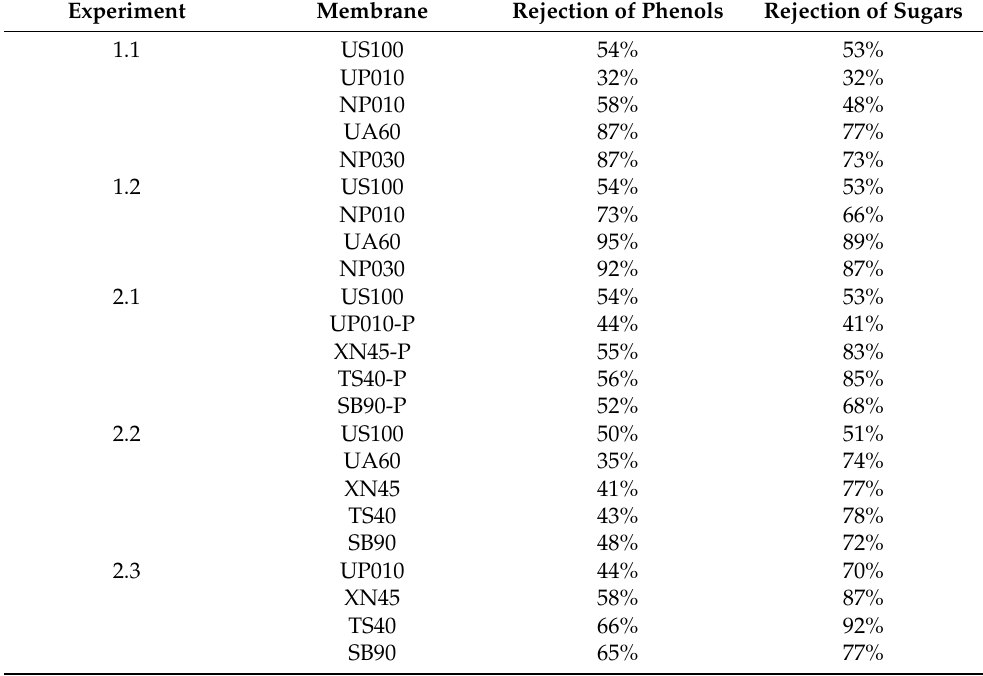
Figure A5. Permeate flow rates observed in the membrane treatment scheme after hydrolysis in which one ultrafiltration step (( a ) UP010) was used and the permeate from the 10,000 Da membrane is split into three equal parts and was treated with three different nanofiltration membranes (( b ) XN45, ( c ) TS40, ( d ) SB90). Table A1. Apparent rejection of the membranes used in the experiment with two UF steps (1.1) and one UF step (1.2) prior to the NF membranes, prior to oleuropein hydrolysis and the experiments with two UF steps (2.1), one loose UF step (2.2), and one tight UF step (2.3) prior to NF, after oleuropein